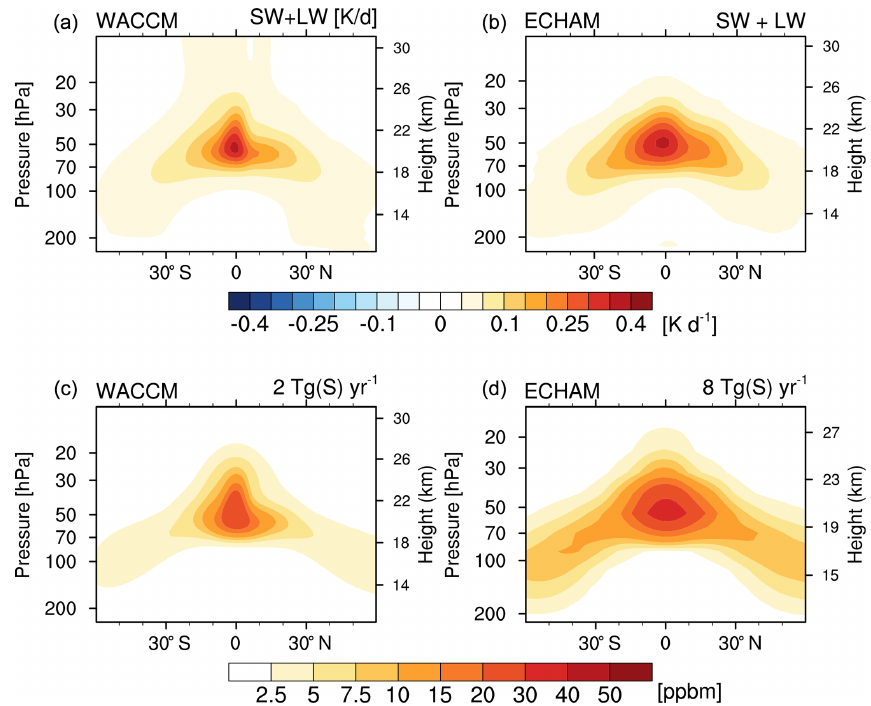
Figure 9. (a, b) Heating rate (Kd − 1 ) and (c, d) sulfate concentration of a 2Tg ( S ) yr − 1 injection rate in WACCM (a, c) and an 8Tg ( S ) yr − 1 injection rate in ECHAM (b, d) . Injection rates were chosen to result in similar temperature anomalies in both models. Intervals of the heating rates (a, b) are 0.01, 0.05, 0.1, 0.15, 0.2, 0.25, 0.3, 0.35 and 0.4Kd − 1 .